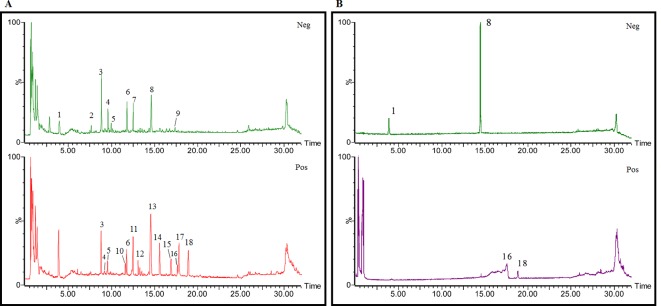
UPLC-Q-TOF chromatograms of GU extraction and Standers (A); Standers (B).